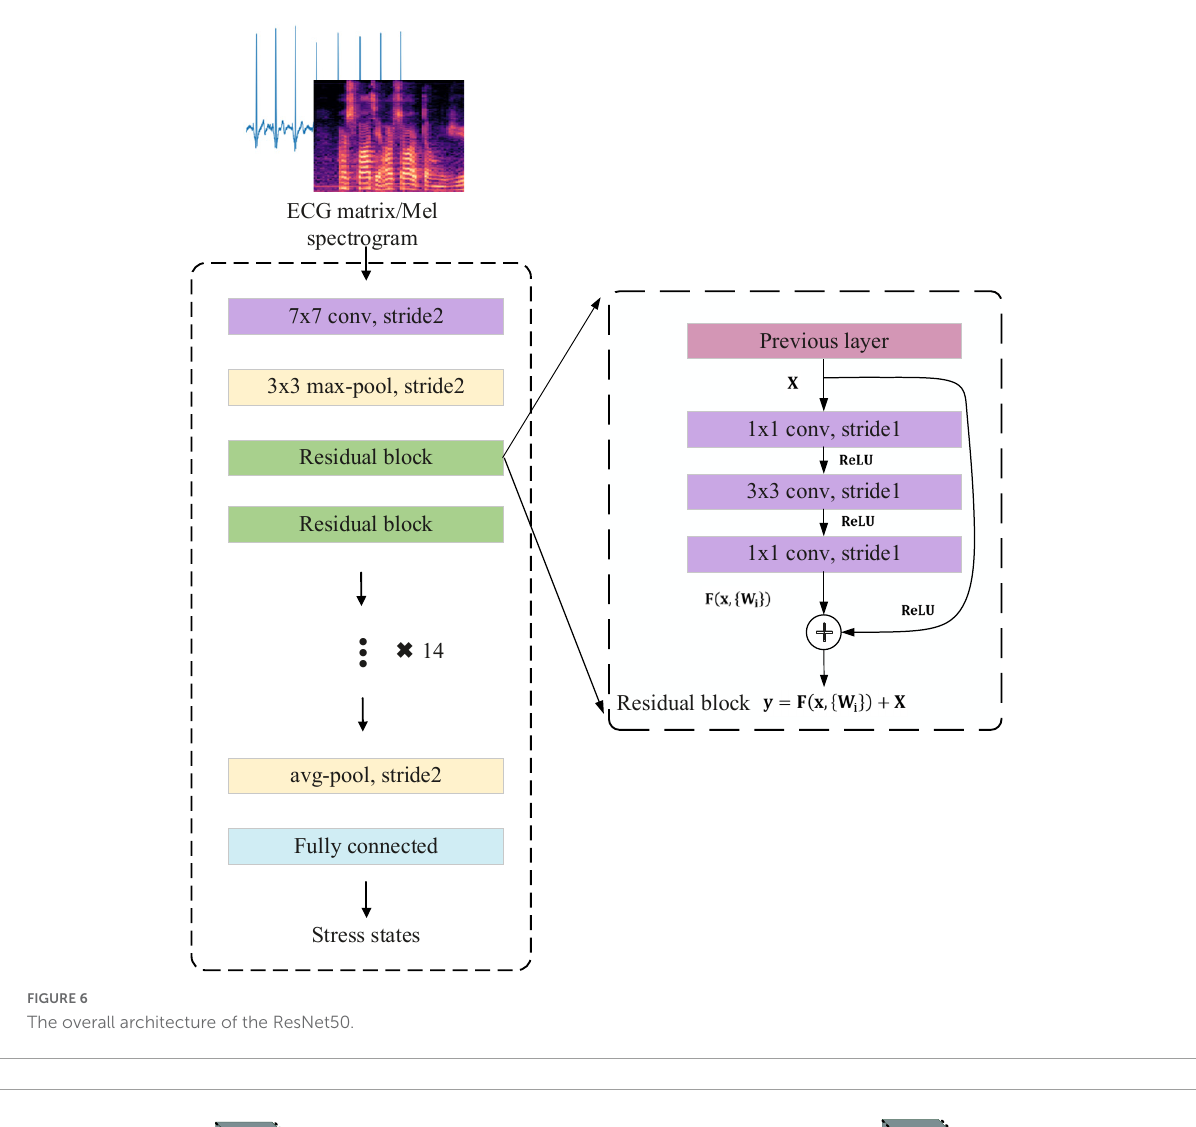
FIGURE6 The overall architecture of the ResNet50.